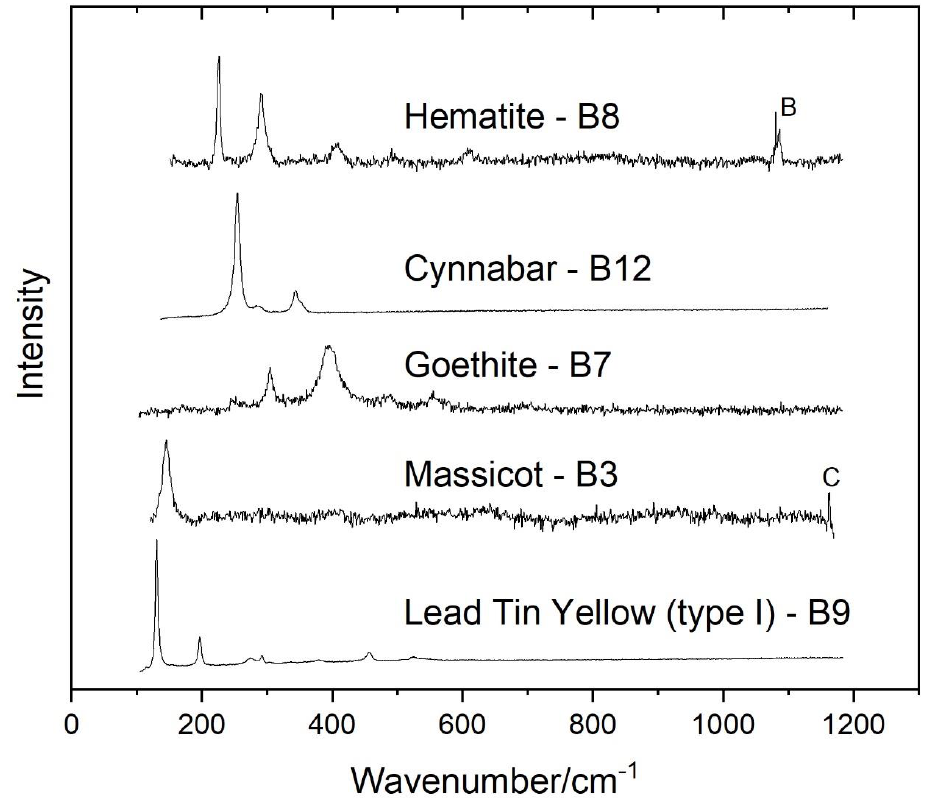
Figure 6. Raman spectra of red and yellow pigments. B = White lead, C = Calcite.